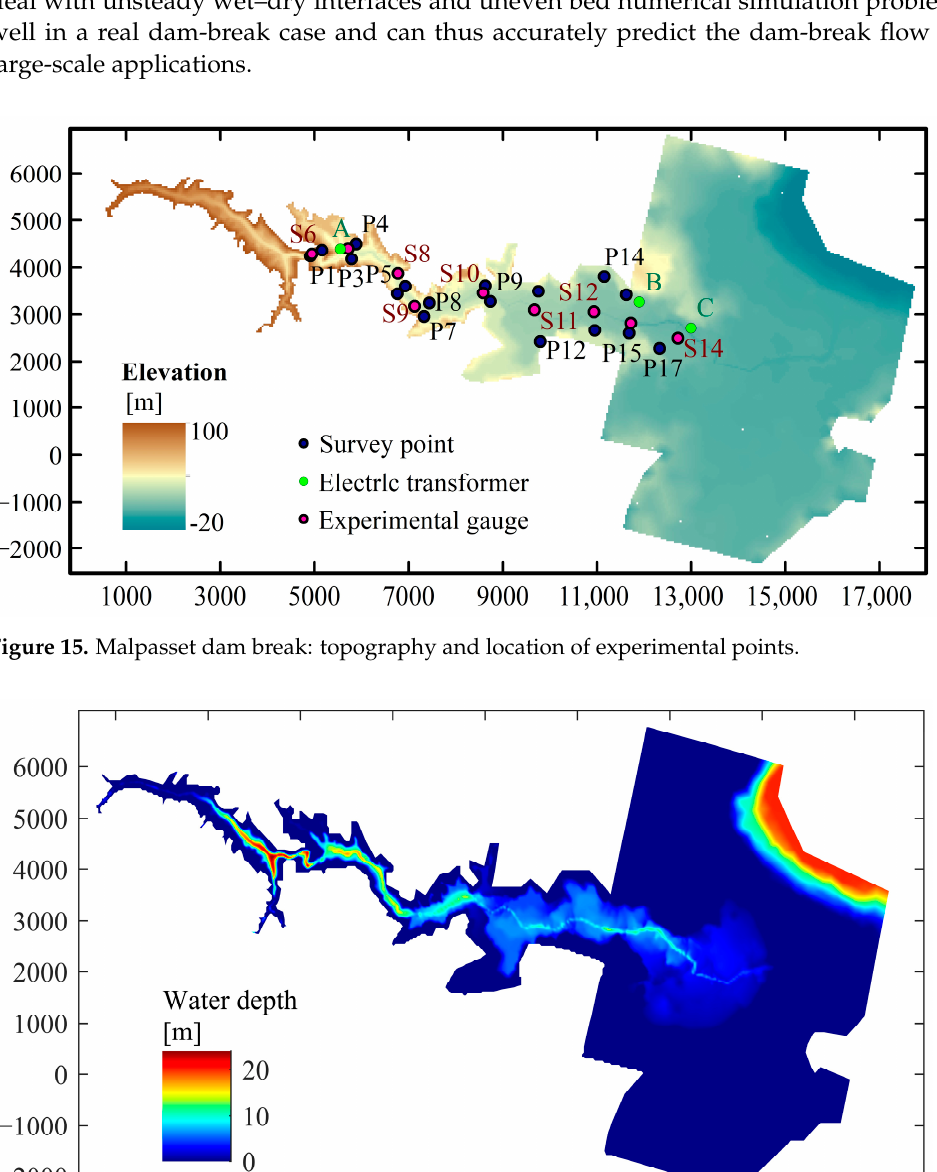
Figure 15. Malpasset dam break: topography and location of experimental points.